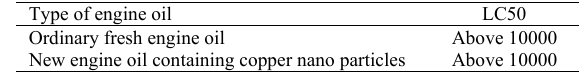
Table 11. LC50 levels in artificial soil after 14 in mg/kg artificial soil test Table 11: LC50 levels in artificial soil after 14 in mg/kg artificial soil